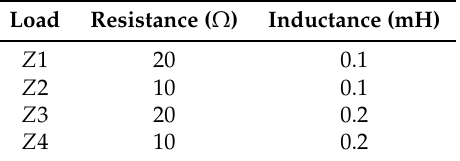
Table 2. Load parameters of the MMC.